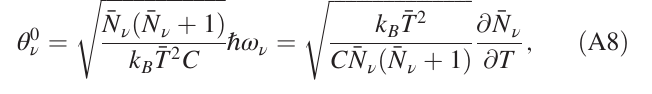
ffiffiffiffiffiffiffiffiffiffiffiffiffiffiffiffiffiffiffiffiffiffiffiffiffiffiffi